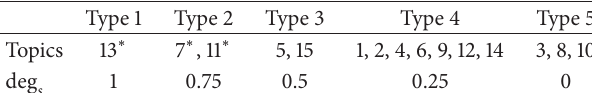
Table 5: 5 types of